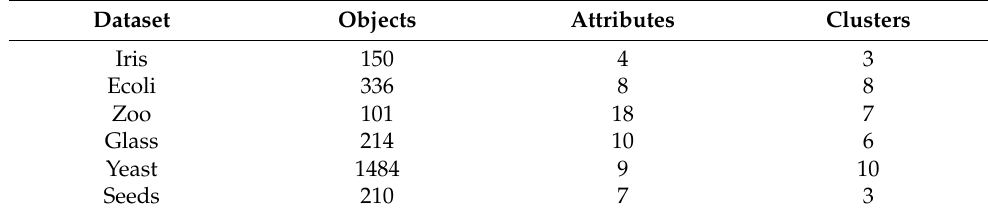
Table 7. The basic information of the six UCI